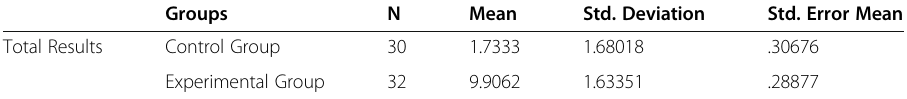
Table 2 Group Statistics of Control and Experimental Groups Groups N Std.